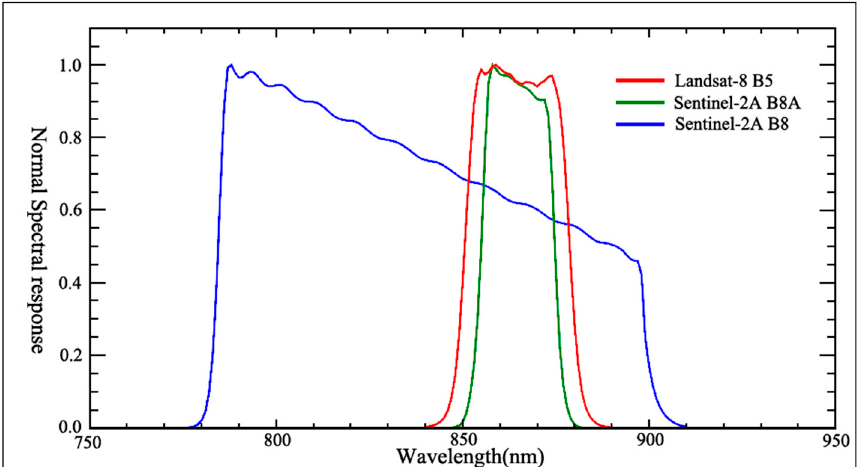
Figure 6. The comparison of spectral response functions of Landsat-8 NIR band (B5) and Sentinel-2 bands 8 and 8A [52]. Table 3. Sentinel-2 data band ratios as an analogue of ASTER, Landsat 5 TM and Landsat 8 Operational Land Imager (OLI)band ratios for mapping iron-bearing minerals, modified after [12,51,54,55].